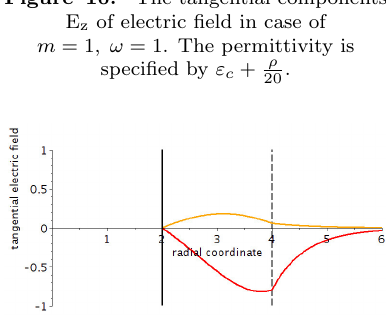
Figure 12. The tangential components Figure 13. The tangential components E z of electric field in case of H z of electric field in case of m = 3 , ω = 1. The permittivity is m = 3 , ω = 1. The permittivity is . specified by ε c + ρ − 2 specified by ε c + ρ − 2 2 2